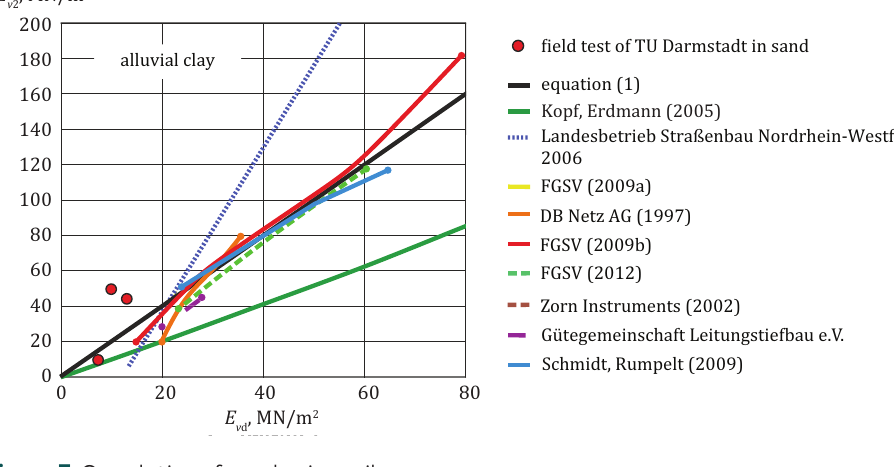
Figure 7. Correlations for cohesive